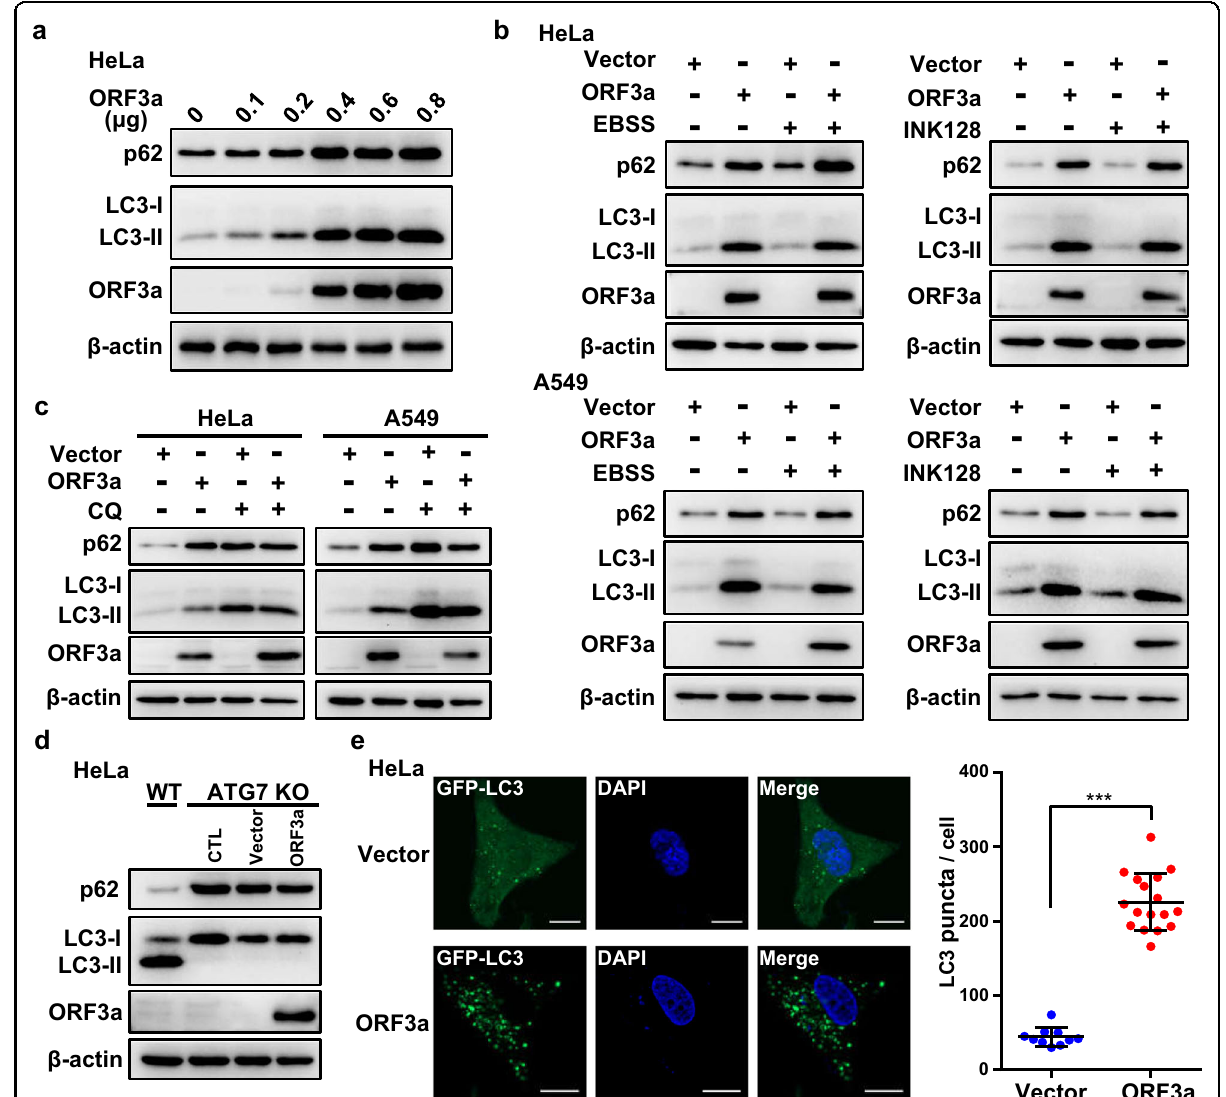
Fig. 2 SARS-CoV-2 ORF3a blocked autophagy and caused the accumulation of autophagosomes. a ORF3a inhibited autophagy in a dose- dependent manner. Increasing amounts of SARS-CoV-2 ORF3a-expressing plasmids were transfected into HeLa cells, and the effect on autophagy was analyzed by detecting the protein levels of p62 and LC3-II. b ORF3a inhibited autophagy under autophagy-inducing conditions. ORF3a was expressed in HeLa or A549 cells with or without EBSS or INK128 treatment. The protein levels of p62 and LC3-II were then analyzed. c ORF3a cannot further inhibit autophagy under autophagy-blocking conditions. ORF3a was expressed in HeLa or A549 cells with or without subsequent treatment with CQ (chloroquine). The protein levels of p62 and LC3-II were then analyzed. d ORF3a cannot further inhibit autophagy in autophagy-blocked HeLa cells with the ATG7 gene knocked out. e ORF3 expression caused the accumulation of autophagosomes. ORF3a was expressed in HeLa cells with stable expression of GFP-LC3. Puncta of GFP-LC3 (representing autophagosomes) were observed and counted. Scale bars, 0.5 μ